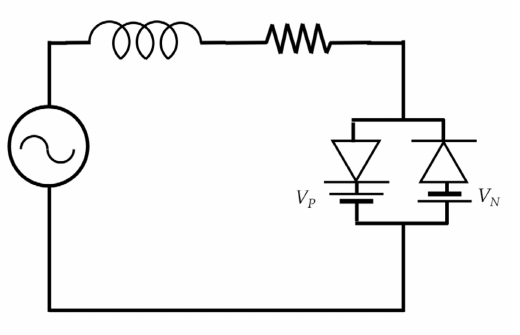
Figure 8. HIF model of A.E. Emanual